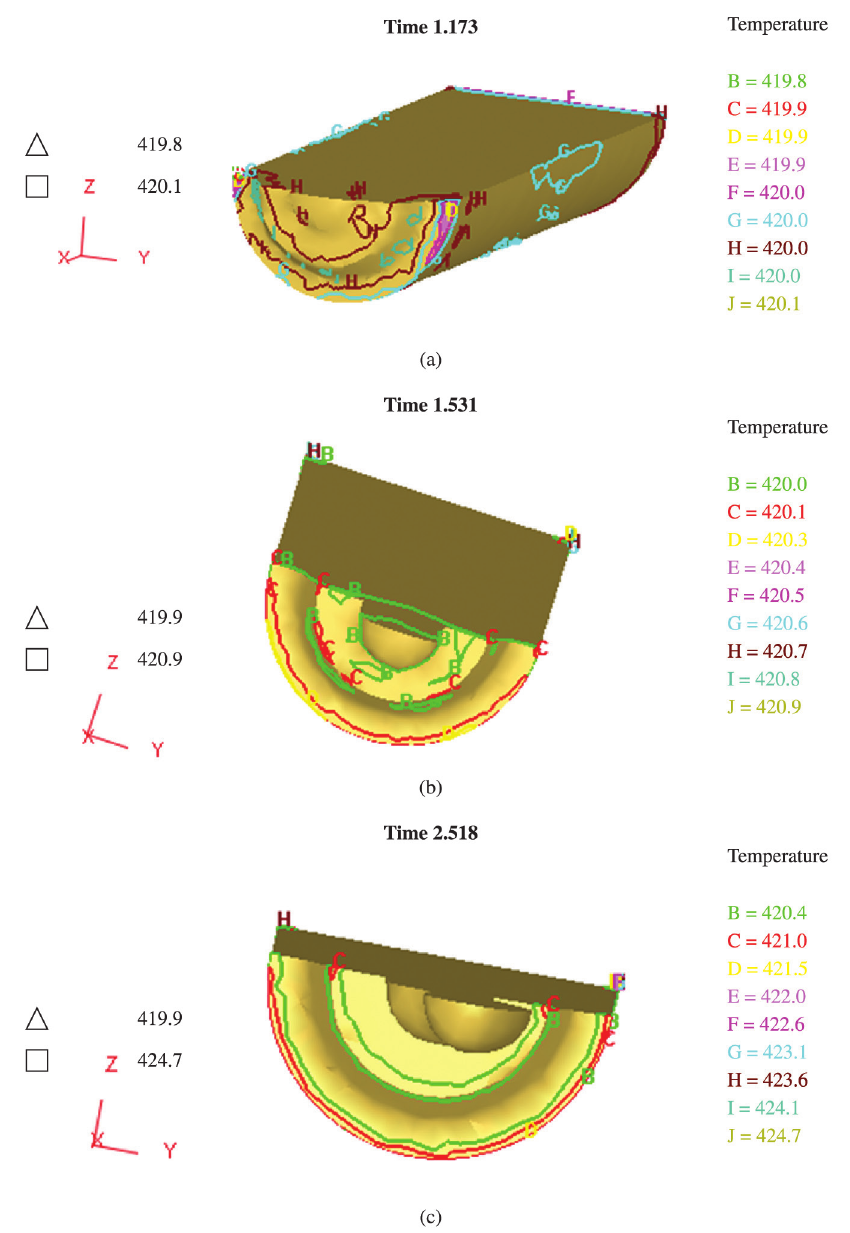
Figure 7. The evolutions of temperature contours in Mg billet during different ES